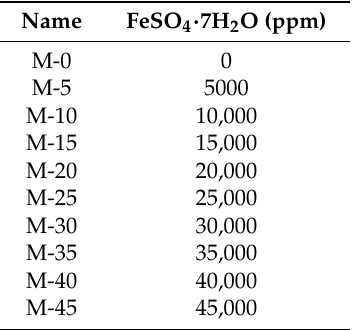
Table 4. Mix proportions utilized for the cemented paste backfill (CPB) preparation (Tailings is ST, binder is CPC, percentage of binder dry weight is 10%, water cement ratio is